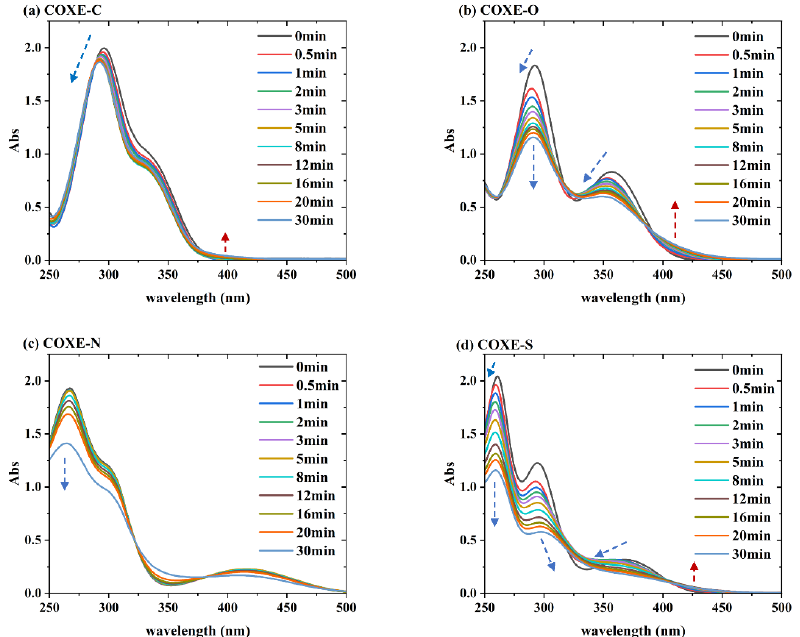
Figure 6. Steady-state photolysis curves measured for ( a ) COXE-C, ( b ) COXE-O, ( c ) COXE-N and ( d ) COXE-S in acetonitrile under 400 nm LED irradiation (light intensity = 100 mW · cm − 2 ) at room temperature.